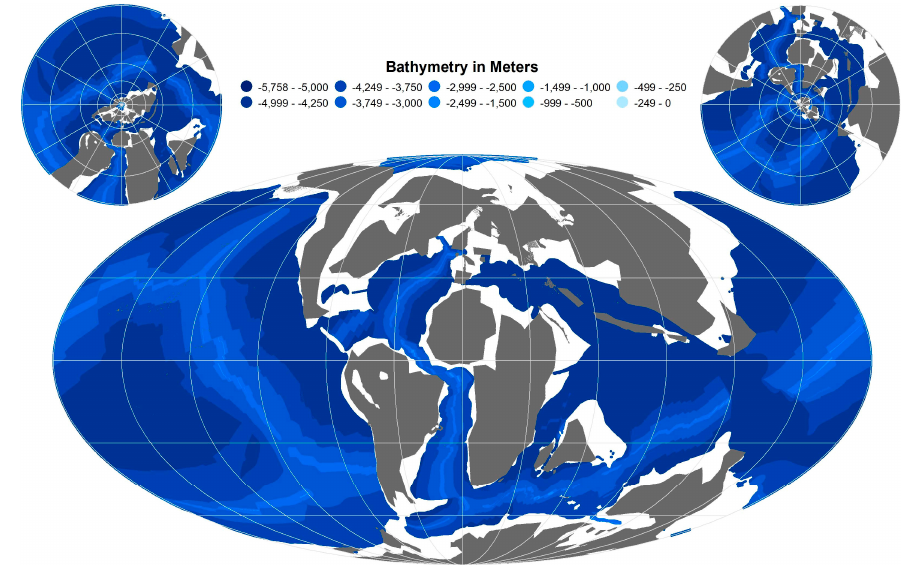
Figure 5. Depth-to-basement, with isostatically adjusted, multicomponent sediment layer at 94 Ma. The parts of the ocean basins that occupy the transitional zone between oceanic crust and the emergent continental crust are termed here as “shelf-slope-rise” regions. These regions typically extend from the boundary of open ocean regions to the coastline. The three-parameter “shelf-slope-rise” model from Goswami [35], based on analysis of various modern shelf-slope-rise structures at active and passive margin regions from ETOPO1, along with their corresponding sediment thicknesses taken from [51], was used to reconstruct the C–T “shelf-slope-rise” regions, extending from the maximum extent ocean crust to the coastlines (Figure 6).